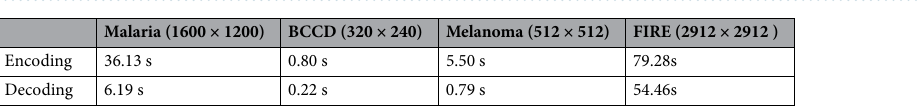
Table 4. The average encoding and decoding time of an image on different datasets with soft